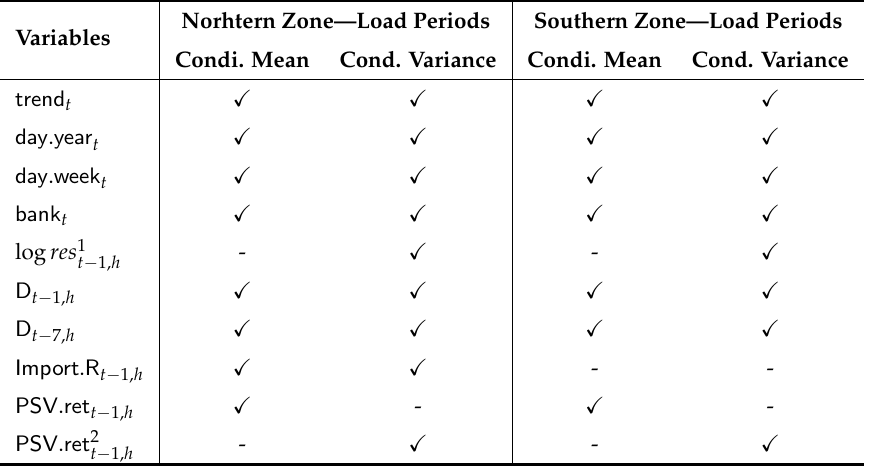
Table 5. Variables included in the predictive models for the conditional mean and conditional variance of